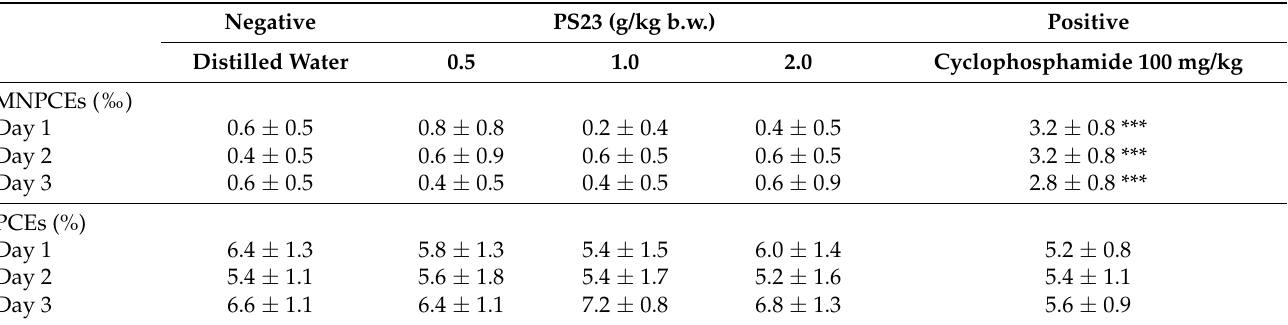
Table 4. Micronucleus test of PS23 on male ICR